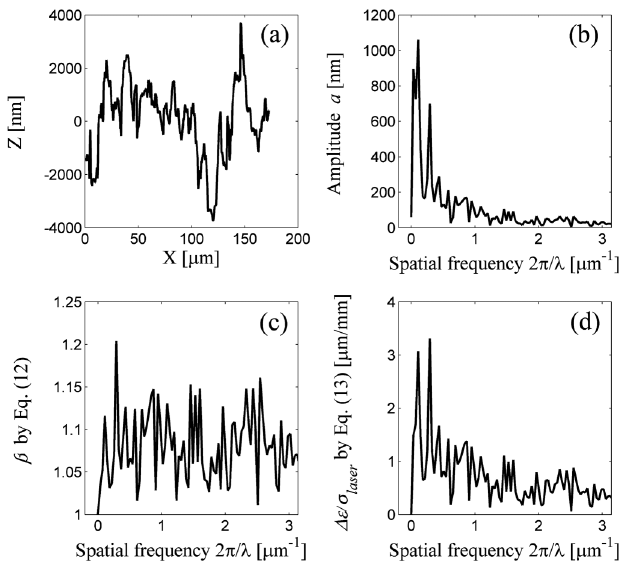
FIG. 8. Surface roughness analysis of the dashed line in Fig. 7(c): (a) surface perturbation profile, (b) spatial frequency spectrum, (c) field enhancement factor, and (d) roughness emit- tance growth at 50 MV = m .